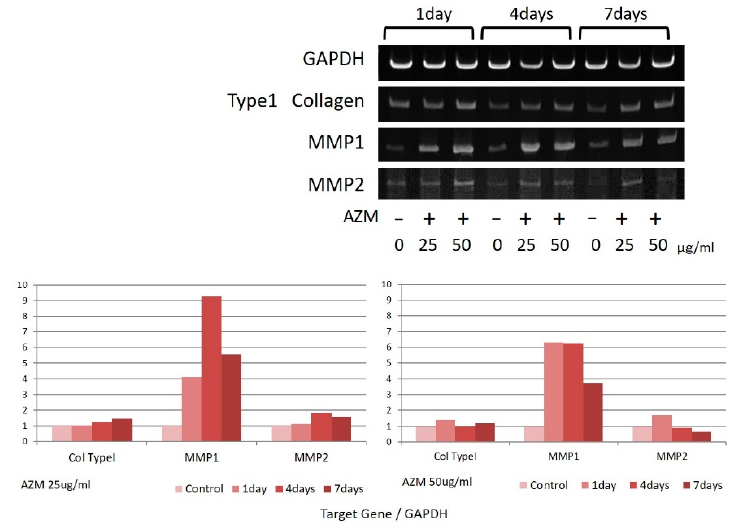
Figure 10. Gene expression of Type I-Collagen, MMP-1, and MMP-2 in hGFs due to the influence of AZM. The most representative data were shown.